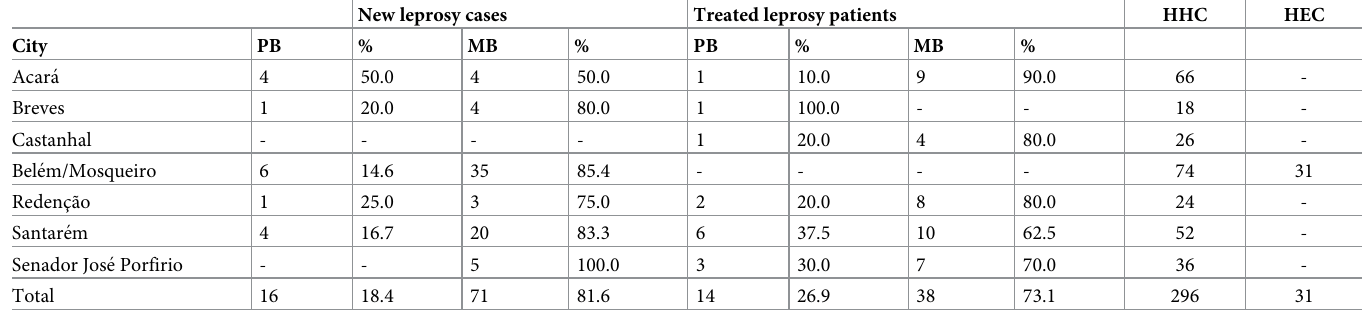
Table 1. Operational classification and number of subjects per group and municipality. Characteristics of newly diagnosed leprosy patients, treated leprosy patients, healthy household contacts (HHC) and healthy endemic controls (HEC) from the seven cities surveyed.